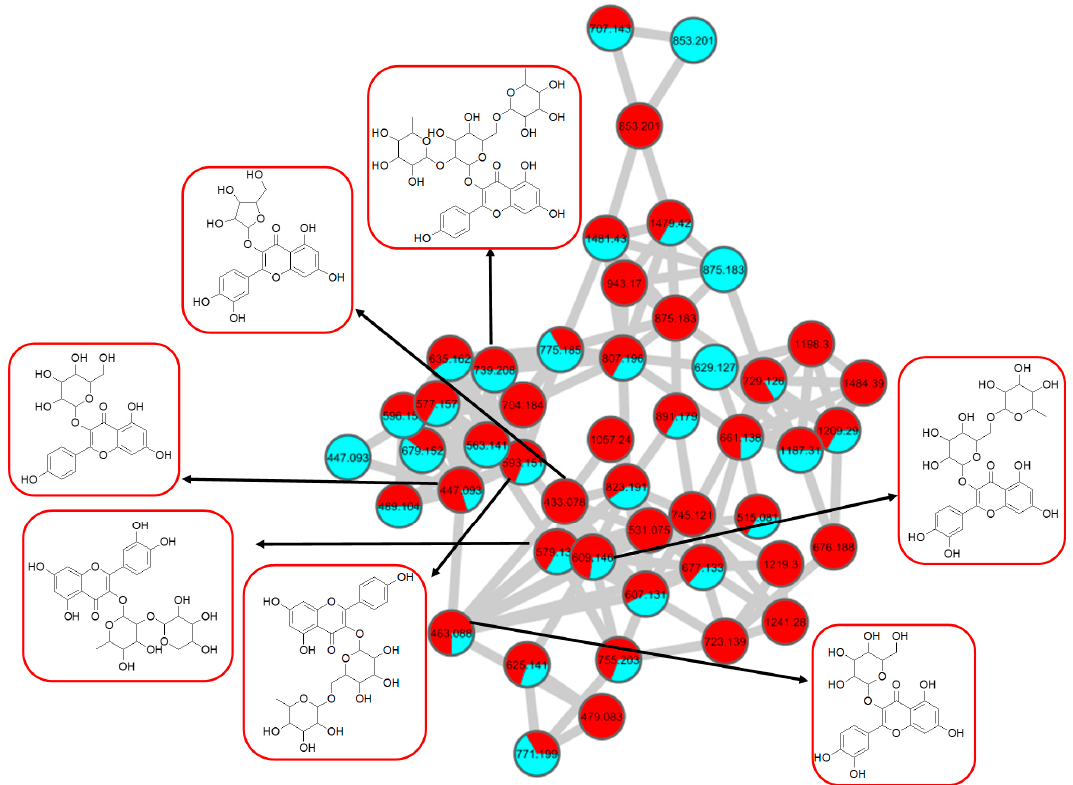
Figure 8. Flavonol 3-O-glycoside (cluster A in negative mode) from the full molecular network (MN) of ethyl acetate fraction of flower C. ternatea (CTF_EA) extract. The metabolites in red boxes were annotated based on the GNPS library matching.